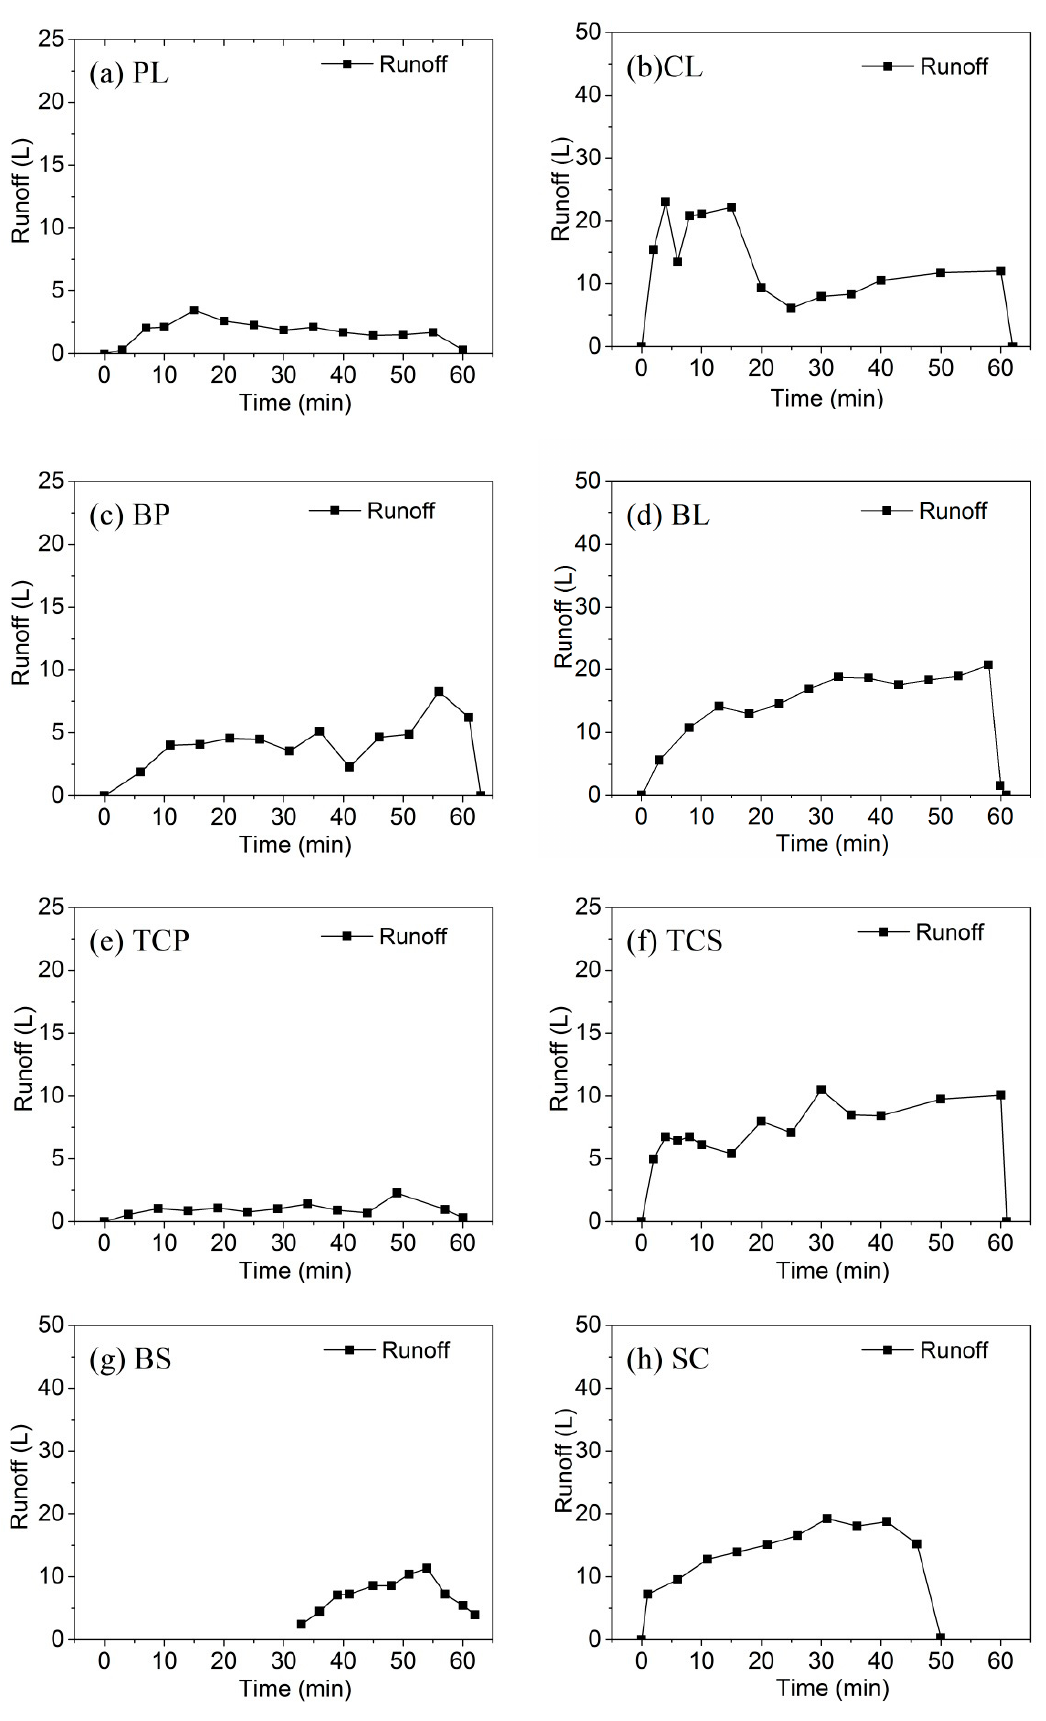
Figure 4. Runofft yields under different crop types. Figure 4. Runo ff t yields under di ff erent crop